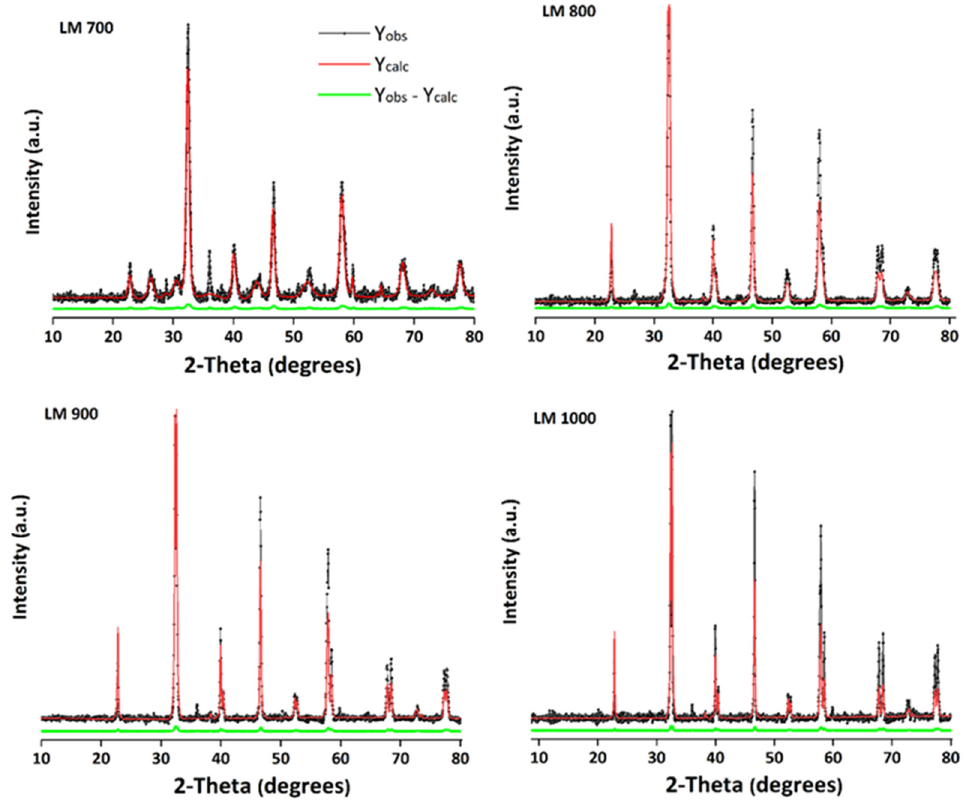
Figure 3. The Rietveld refinement plots for LM 700, LM 800, LM 900, and LM 1000. Table 2. Grain and particle size of LaMnO 3